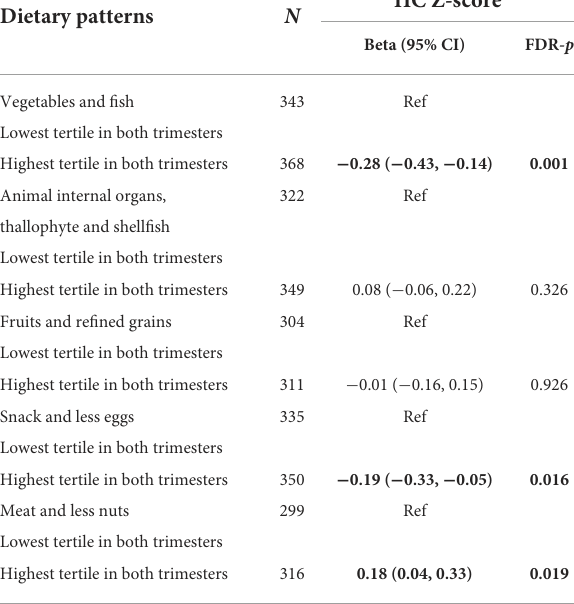
TABLE 3 Adjusted associations of tertiles of dietary patterns in the second and third trimester with fetal HC Z-score. Dietary